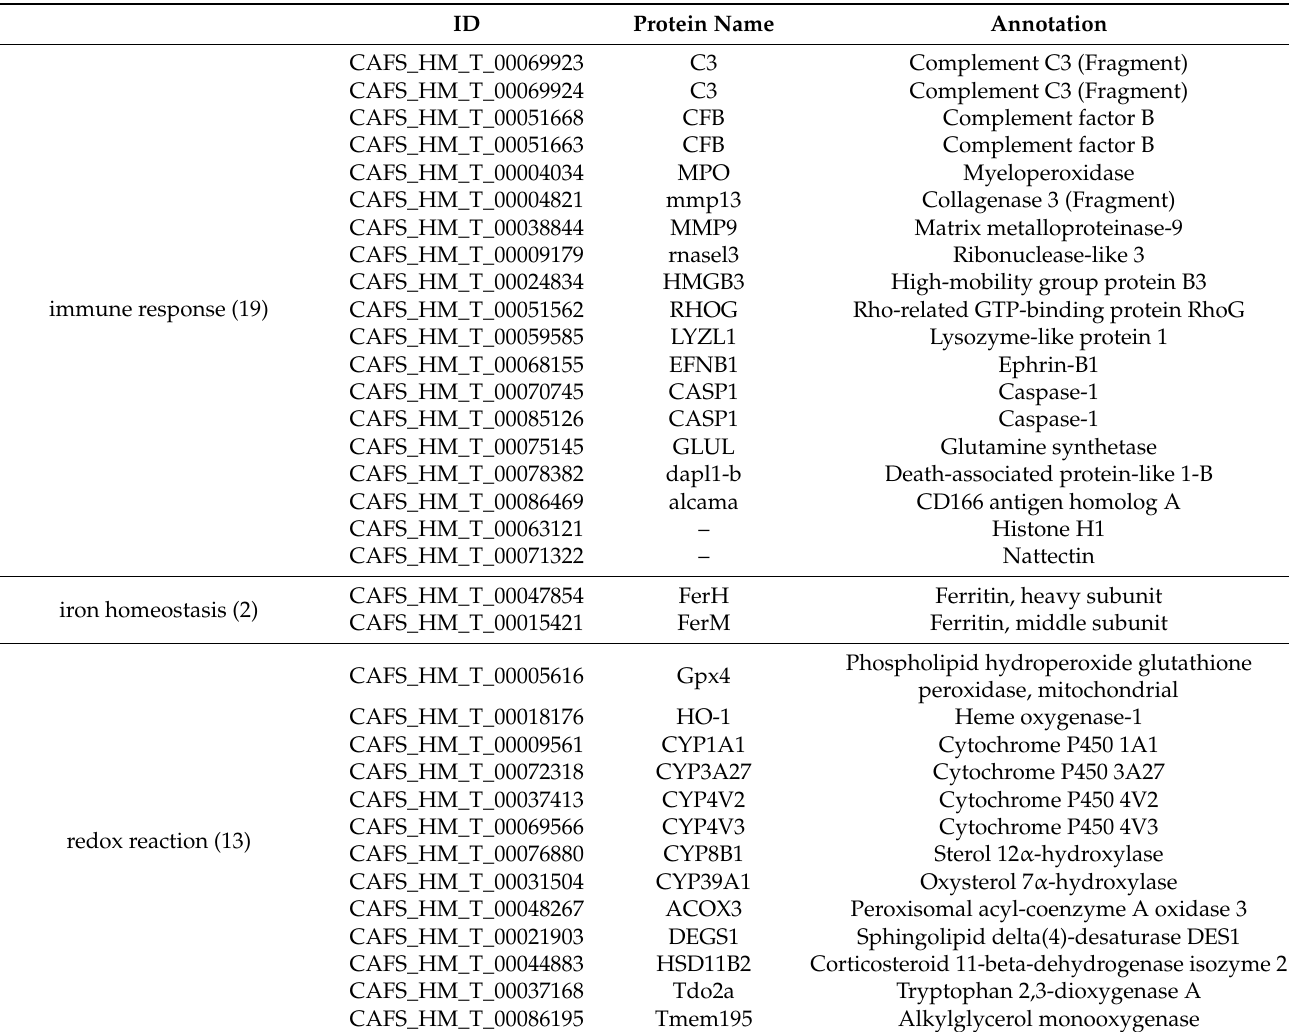
Table 1. DEPs involved in immune response, iron homeostasis, and redox reaction in the liver under